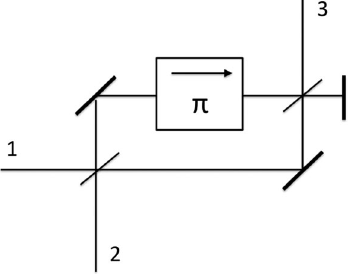
FIG. 4. Hogan ’ s interferometric implementation [22,23] of the three-port circulator using one gyrator, using quasioptical nomenclature. One of the beams emerging from the Mach- Zehnder interferometer is reflected back into the structure with a mirror. In Hogan ’ s original discovery, magic tees are employed rather than half-silvered mirrors (in microwave parlance, these are directional